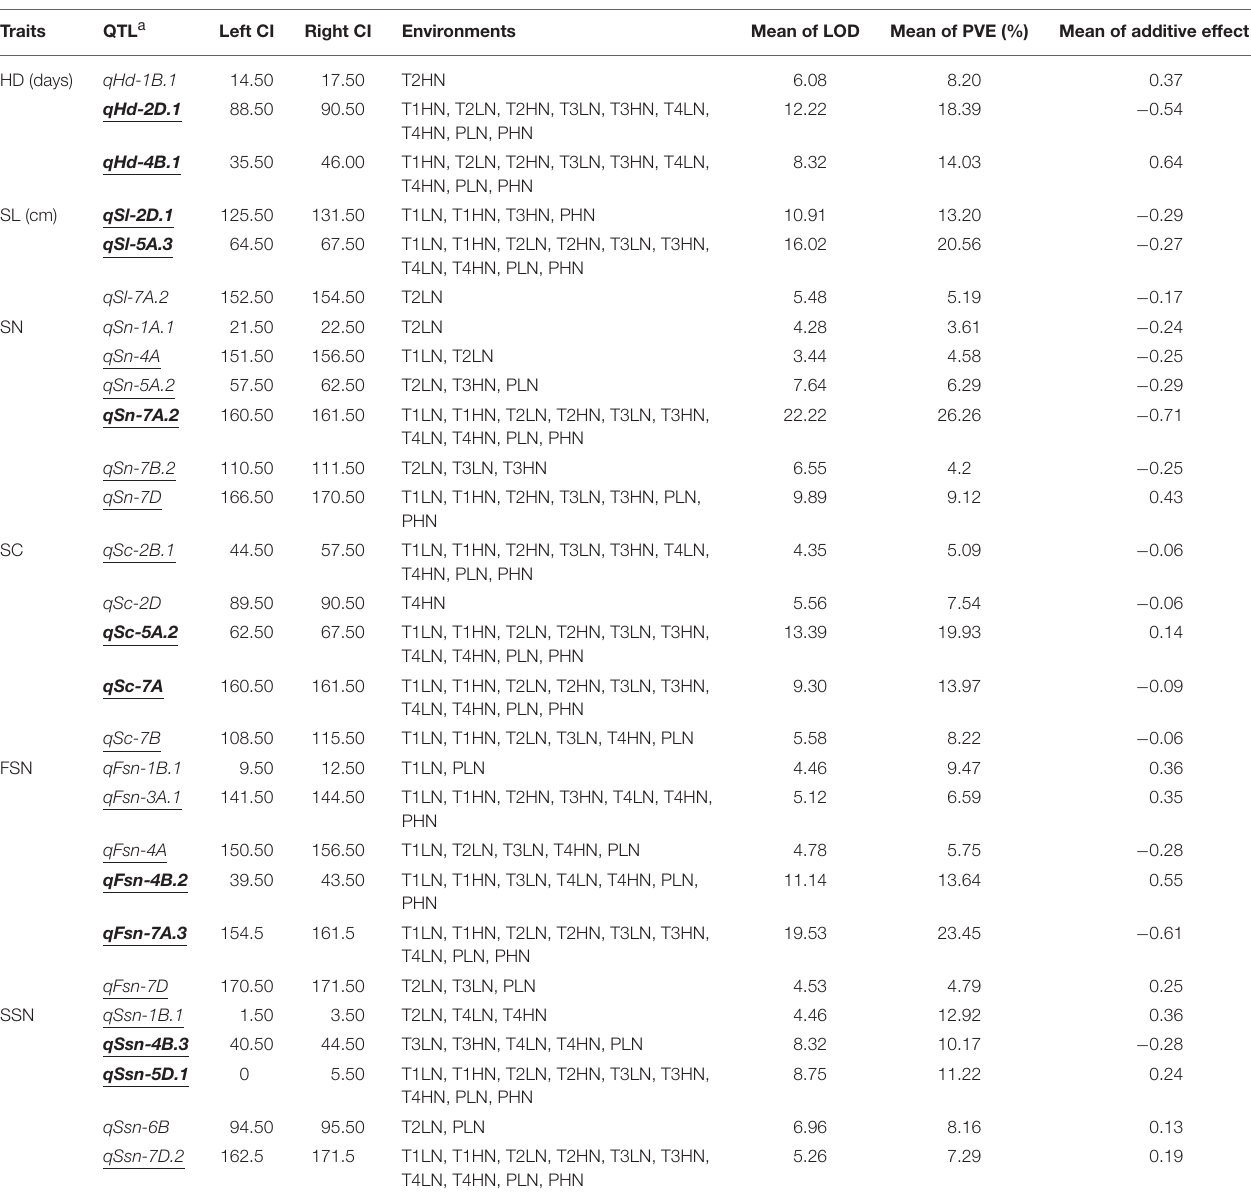
TABLE 1 | The stable QTL detected in this study. Traits Right CI Environments Mean of LOD Mean of PVE (%) Mean of additive